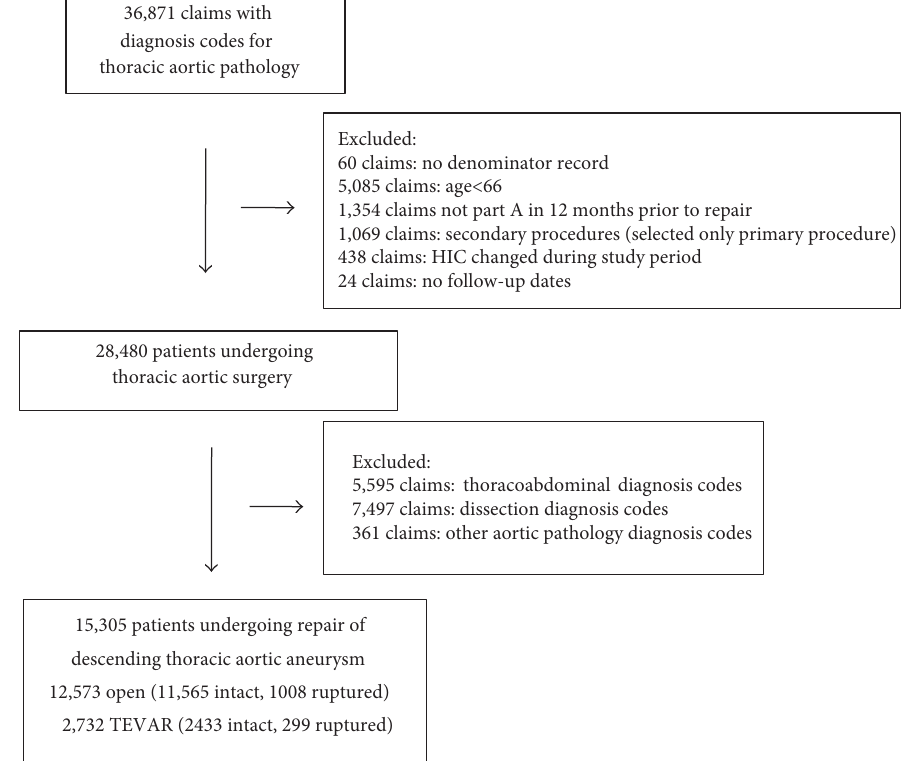
F 1: Establishing the cohort of patients undergoing TAA